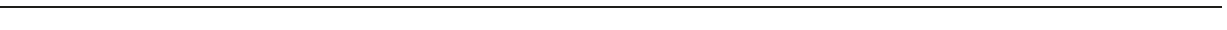
Fig. 3 Nucleolar stress triggered by the perturbation of ribosome biogenesis leads to excessive lipid accumulation. a The general processes of ribosome biogenesis. The fat content percentage of triacylglycerol (% TAG) in total lipids (TAG + phospholipids, PL) of each worm strain was quantitated using TLC/GC analysis. Data are presented as the means ± SD of three biological repeats. b Ribosomal pro fi les of WT, rrp-8 ( kun54 ), rsks-1 ( ok1255 ), and AD- treated worms. c Quanti fi cation of the polysomes. The areas under each peak were calculated using ImageJ software. The fold-change of each peak size for a speci fi c worm strain is presented compared to the 80S peak size of wild type (WT). Data are presented as the means ± SD of three biological repeats. d , f Nile Red staining of fi xed worms. Representative animals; the anterior is indicated on the left, and the posterior is indicated on the right. Scale bar represents 20 μ m. e , g Distribution of the lipid droplet size (% lipid droplets), as measured by Nile Red staining of fi xed worms from d and f , respectively. Data are presented as the means ± SD of 10 animals for each worm strain. h Percentage of triacylglycerol (% TAG) in total lipids (TAG + phospholipids, PL) analyzed by TLC/GC. Data are presented as the means ± SD of four biological repeats. Signi fi cant difference between a speci fi c worm strain and its genetic background strain, Student ’ s t -test, *** P < 0.001, ** P < 0.01, * P < 0.05. NS, no signi fi cant